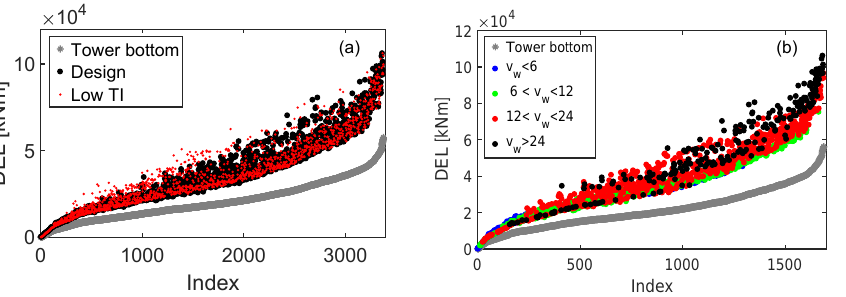
Figure 4. M-DELs as function of ascending T-DELs. (a) M-DELs for design basis (black) and lower turbulence intensity (red). (b) Design basis M-DELs are colored according to the input mean wind speed.